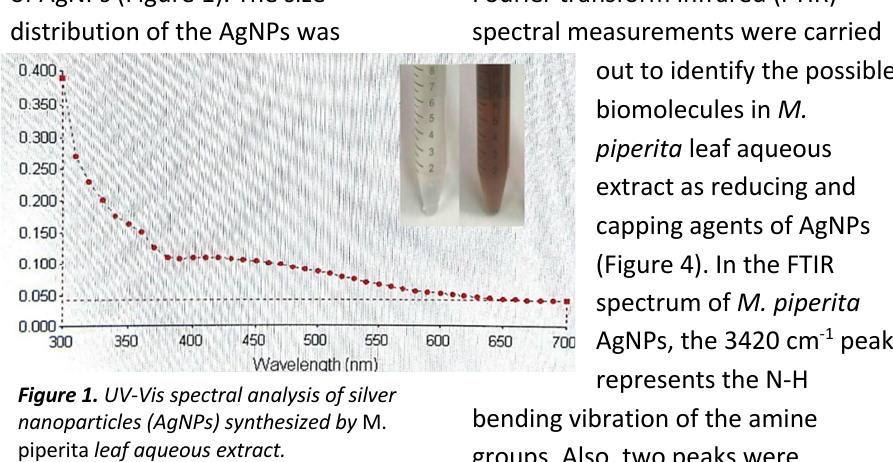
Figure 1. UV-Vis spectral analysis of silver nanoparticles (AgNPs) synthesized by M. piperita leaf aqueous extract.